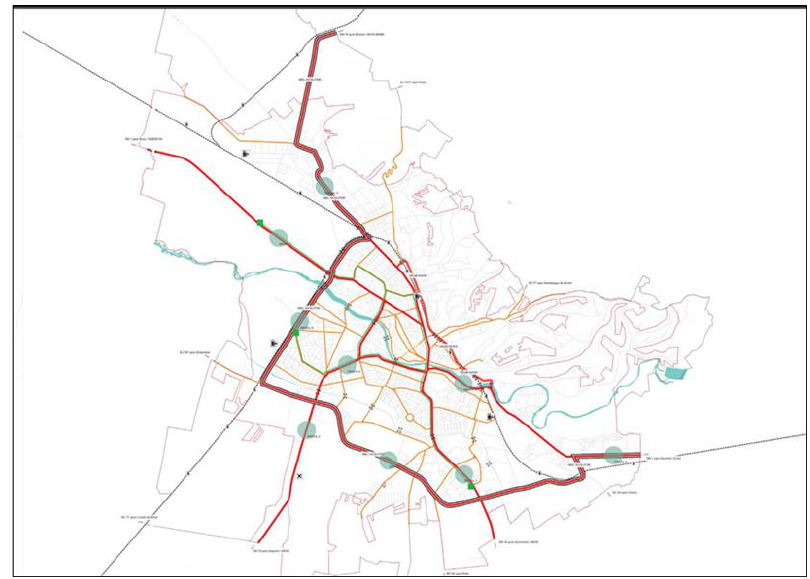
Figure 5. The main road network of Oradea according to the General Urban Plan of Oradea [45].